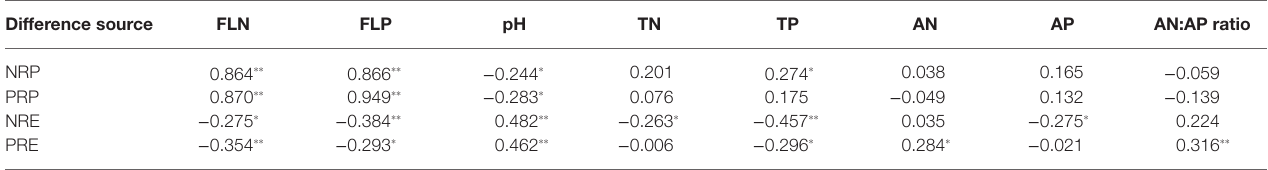
TABLE 2 | Pearson’s correlation coefficients indicating the relationships between N and P resorption proficiency (NRP and PRP), N and P resorption efficiency (NRE and PRE), and NRE:PRE ratio and fresh leaf N and P concentrations and soil characteristics in a Moso bamboo plantation. Difference